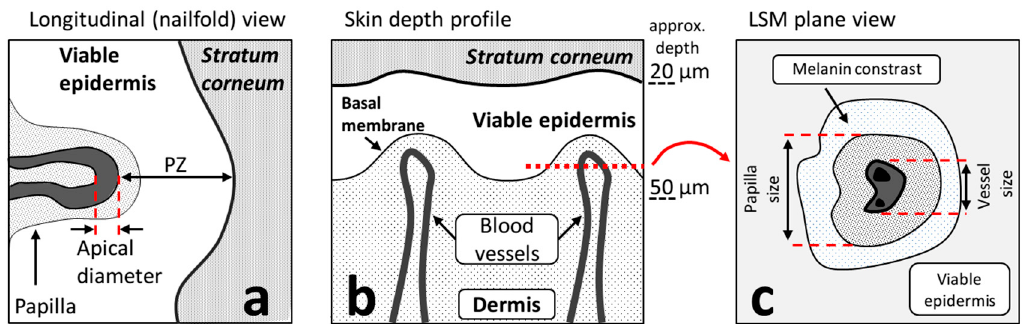
Figure 2. ( a ) Schematic of the nailfold cross-section, as imaged by NVC, and the extracted parameters. ( b ) Schematic of the skin structure. The red dotted line corresponds to the cross-section near the basal membrane. ( c ) Schematic of the typical CLSM image measured near the basal membrane, which includes the cross-section of the dermal papilla and a superficial capillary.